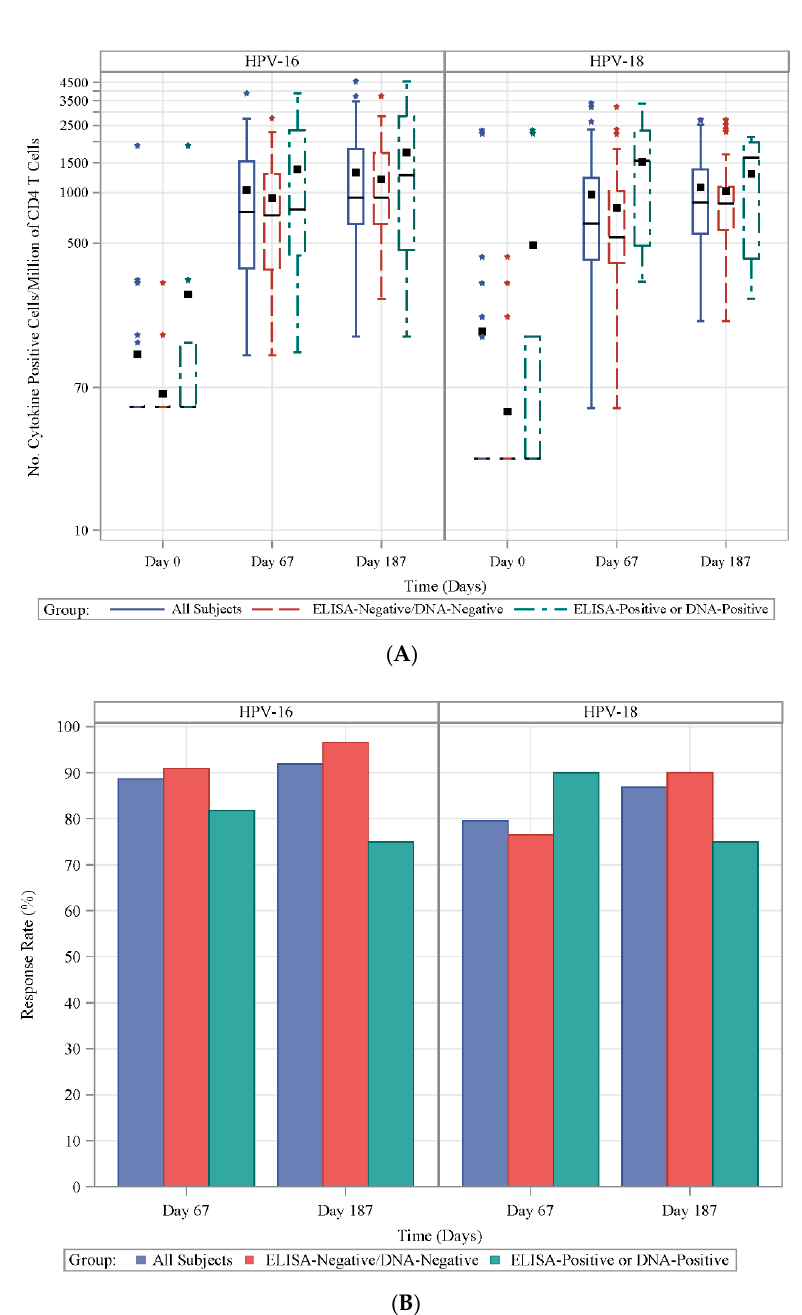
Figure 2. Frequency and proportion of responders of HPV-specific CD4+ T cell induced by 4vHPV vaccination. ( A ) Frequency of HPV-16- (left panel) and HPV-18 (right panel)-specific CD4+ T cell response at Days 0, 67 and 187 in the prospective cohort for all (solid blue line), HPV-naïve (dashed red line) and HPV-exposed (dashed green line) subjects expressed as the number of total IFN γ , IL-2, IL-4 and IL-21 expressing cells per millions of total CD4 T cells; ( B ) proportion of responders for HPV-16- (left panel) and HPV-18 (right panel)-specific CD4+ T cell response at Days 67 and 187 in prospective cohort defined as subjects whose value was greater than the baseline value and with >180 HPV-16+ or >296 HPV-18+ CD4 T cells per million of total CD4 T cells for all (blue bar), HPV-naïve (red bar) and HPV-exposed (green bar) subjects.